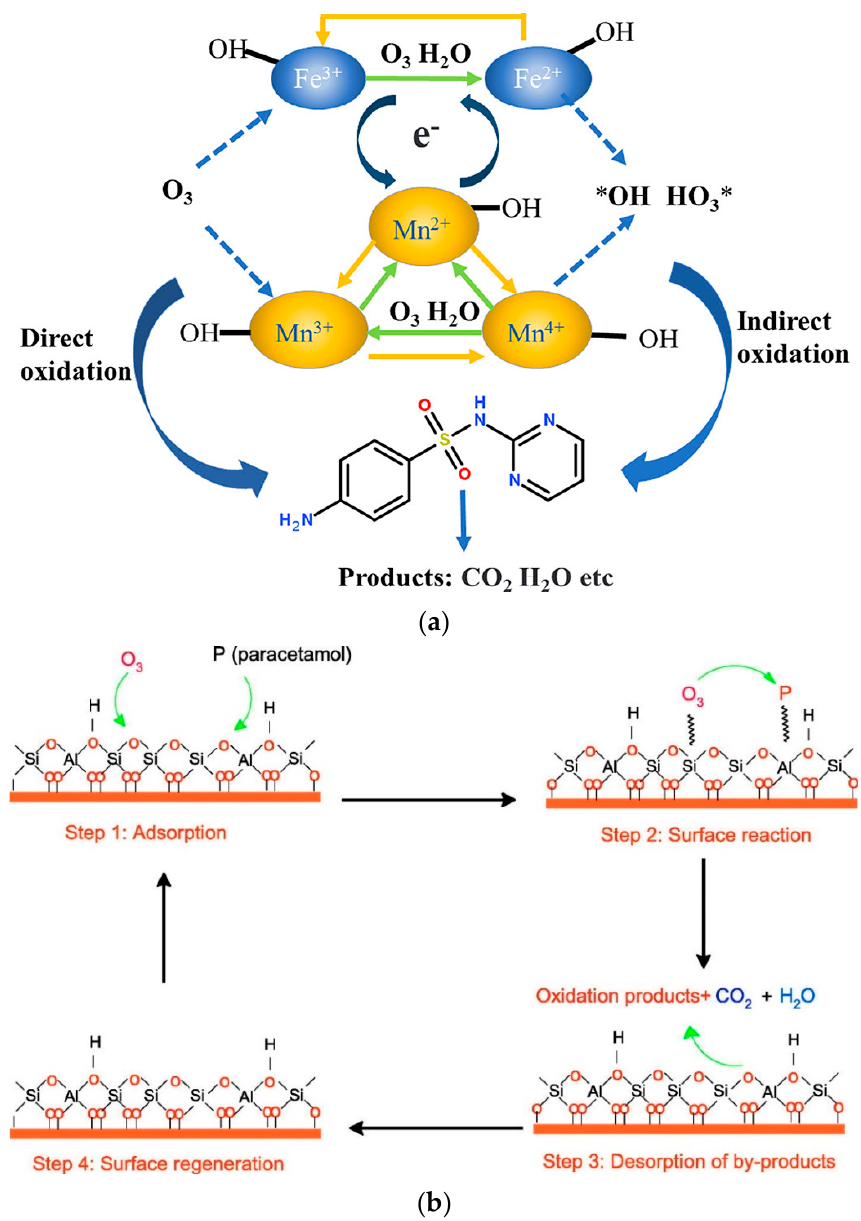
Figure 2. Examples of ( a ) radical [8] and ( b ) non-radical mechanism [10] for the removal of micropollutants during heterogeneous catalytic ozonation.